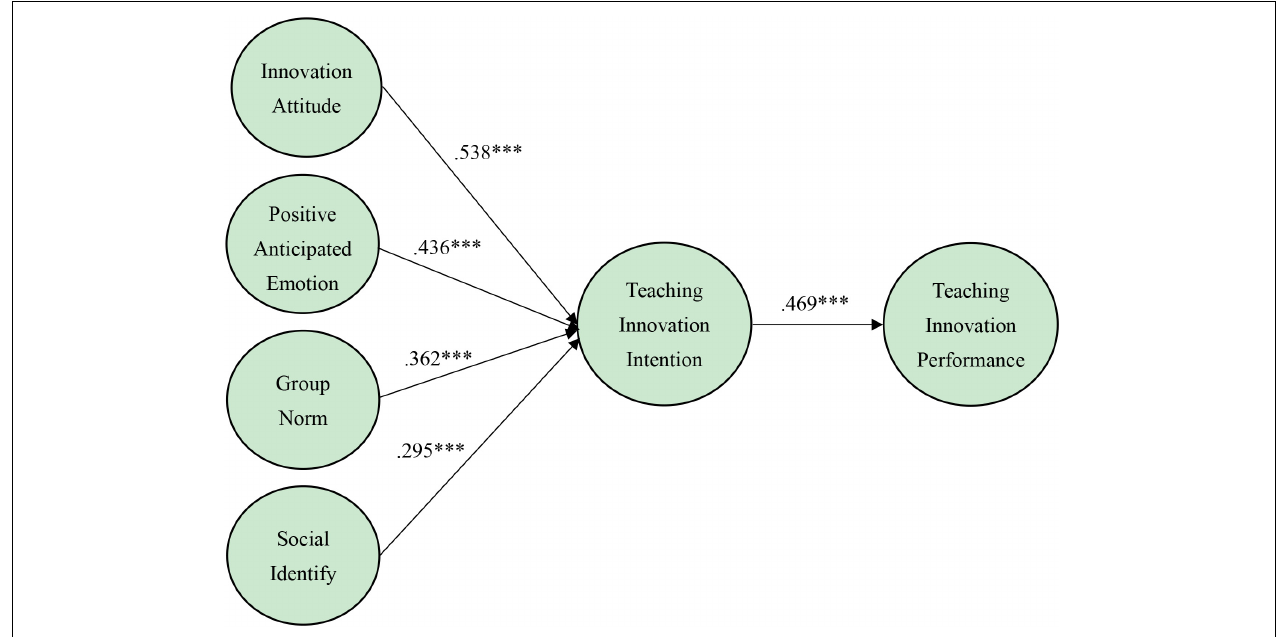
FIGURE 2 | Structural model. ∗∗∗ p <